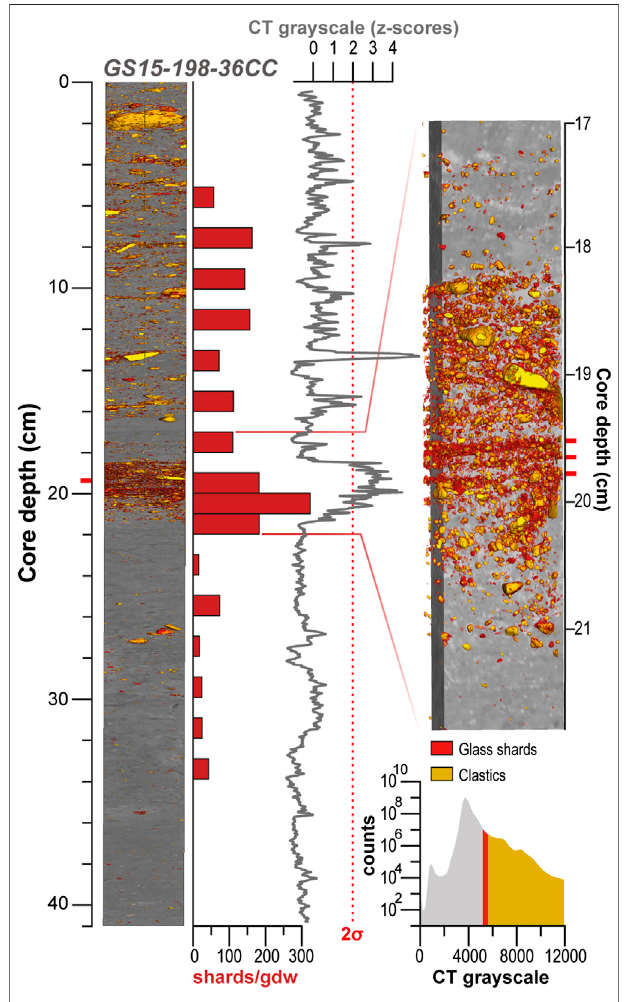
FIGURE 7 | CT scans (2-D orthoslices and 3-D representations) with 1 cm resolution manual shard ( > 80 µm) counts of the analyzed 41 cm section of minerogenic marine core GS15-198-36CC with red bars. The histogram highlights the grayscale value distribution of basaltic tephra (red) and heavier clastic material (orange) dispersed throughout the core (including partial volume effects). Down-core CT grayscale variability is plotted as standardized (z-score) values, and the red stippled line shows the 2 σ range of z-scores. Red dashes indicate horizons detected in both scans and counts. The inset on the right-hand side shows a close-up of the shard maximum around 20 cm depth, highlighting the presence of three closely-spaced cryptotephra horizons or series with red